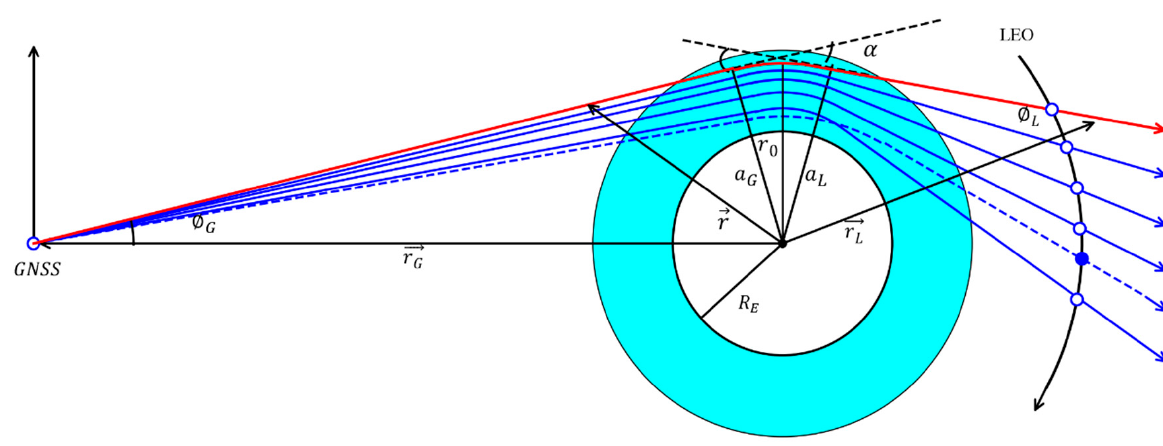
Figure 1. Schematic representation of GNSS RO ray paths (red and blue solid curves) and a multipath ray (blue dashed curve). Some important parameters characterizing the ray paths are: the bending angle ( ∝ ), a radius vector from the Earth’s center (assumed spherical with radius 𝑅 (cid:3006) ) to a point on the ray ( 𝑟⃗ ), the radius vectors at the GNSS and LEO positions ( 𝑟 (cid:3008) (cid:4652)(cid:4652)(cid:4652)⃗) and 𝑟 (cid:3013) (cid:4652)(cid:4652)(cid:4652)⃗) ), the perigee that is defined as the point of the ray that has the shortest distance from the ray to the Earth’s center ( 𝑟 (cid:2868) (cid:4652)(cid:4652)(cid:4652)⃗ ), the impact parameters at the GNSS and LEO positions ( 𝑎 (cid:3008) ) and (𝑎 (cid:3013) ), the ray zenith angle at the GNSS position that is defined as the angle between the radius vector 𝑟 (cid:3008) (cid:4652)(cid:4652)(cid:4652)⃗ and the tangent direction of the ray at the GNSS position ( ∅ (cid:3008) ), and the ray zenith angle at the LEO satellite position that is defined as the angle between the vector 𝑟 (cid:3013) (cid:4652)(cid:4652)(cid:4652)⃗ and the tangent direction of the ray at the LEO position ( ∅ (cid:3013) ).